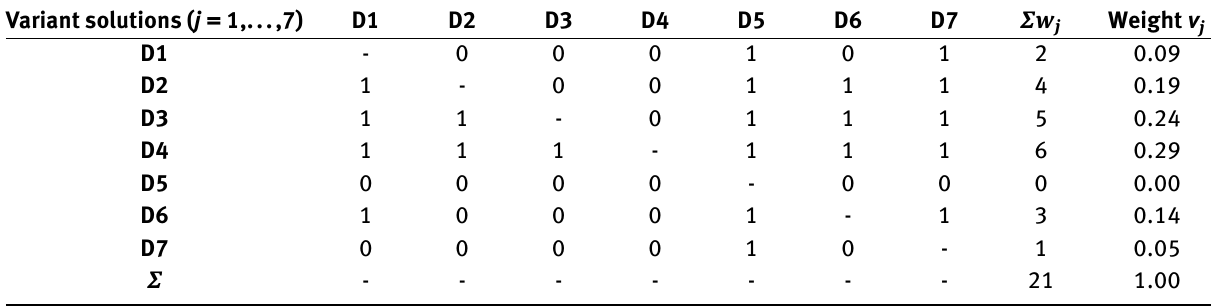
Table 6: Standardization of variant solutions weights’ according to criterion K4 [author]. Variant solutions ( j =